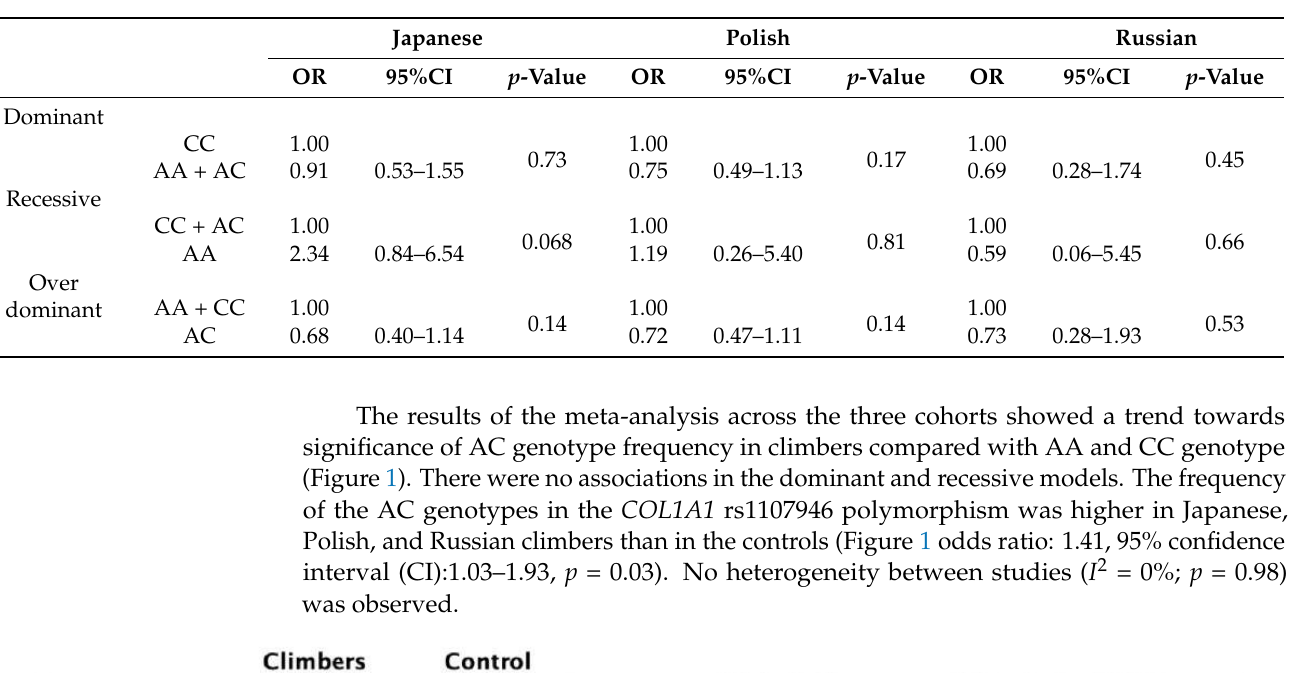
Table 2. Odds ratio of each genetic model (dominant, recessive, and additive) in Japanese, Polish, and Russian climbers.